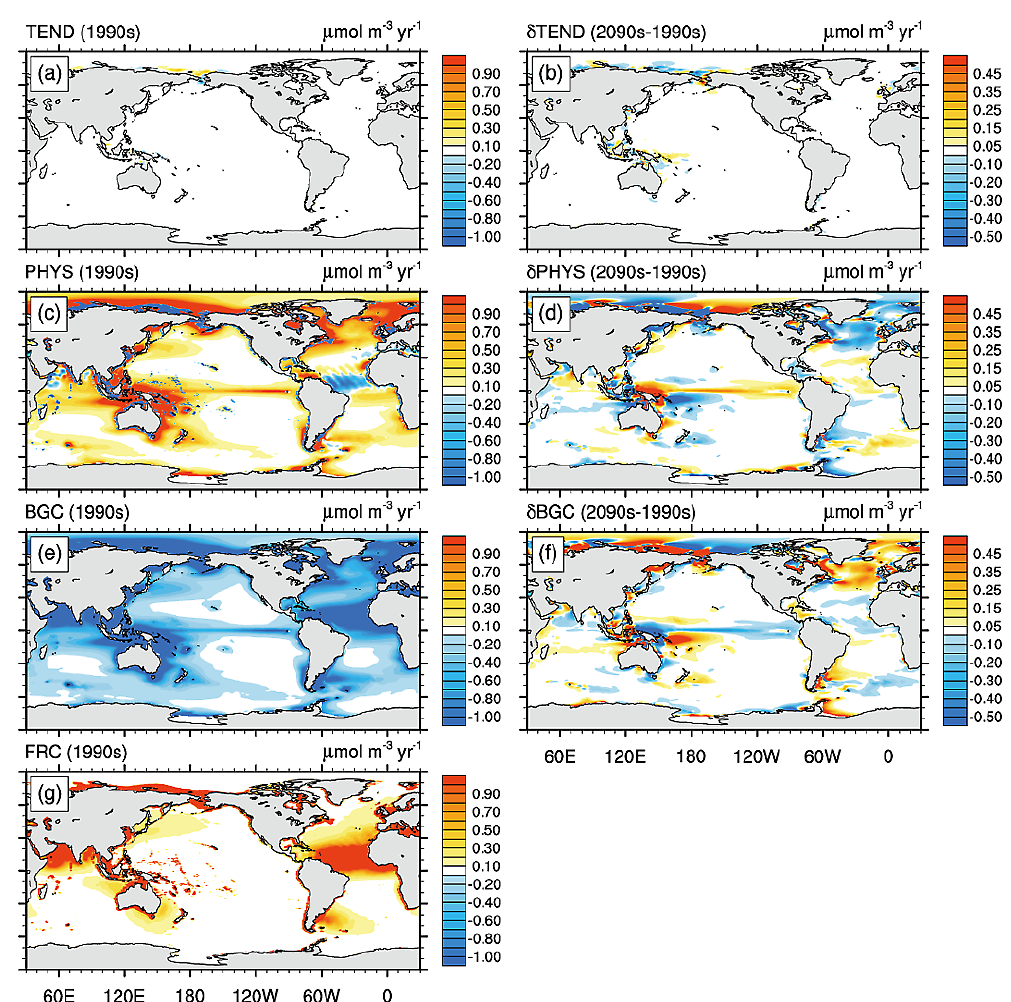
Fig. 6. Spatial distributions of annual-mean dissolved iron tendency (µmolm − 3 yr − 1 ) averaged over the upper 100m during the 1990s ( a , c , e , and g ) and the differences between the 2090s and 1990s ( b , d and f ) for the TEND ( a and b ), PHYS ( c and d ), BGC ( e and f ), and FRC (g)